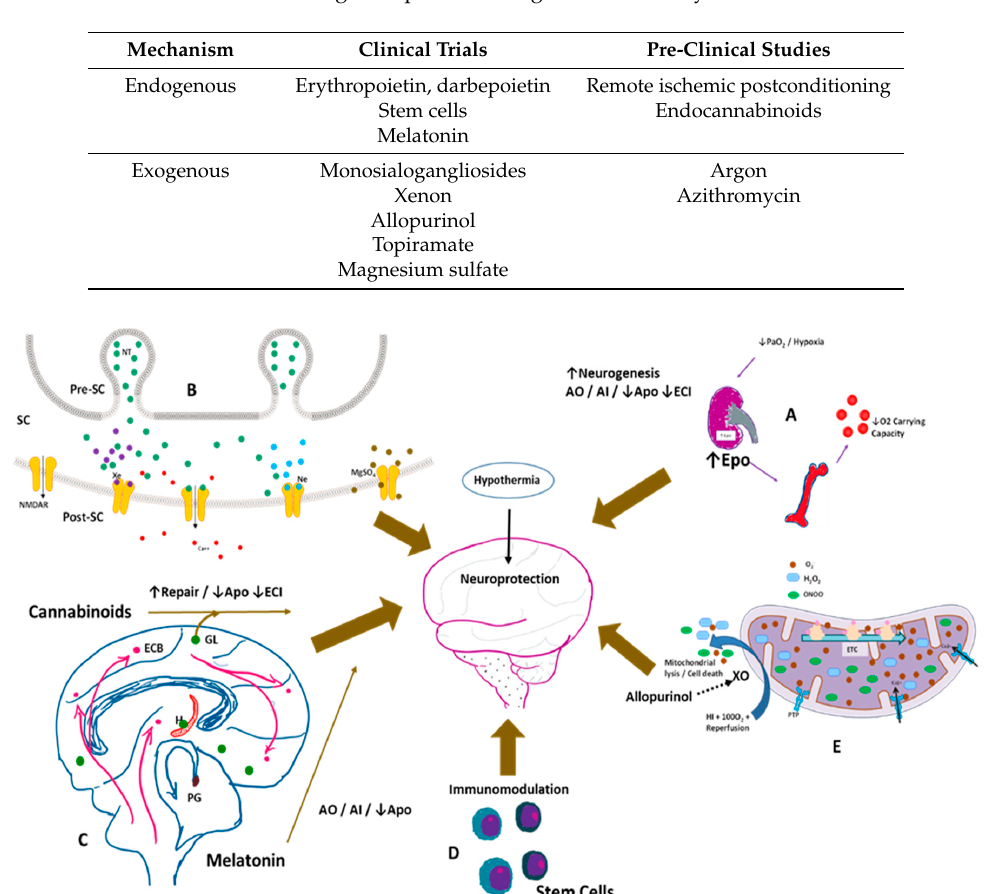
Table 1. Promising therapies in management of HIE by mechanism.